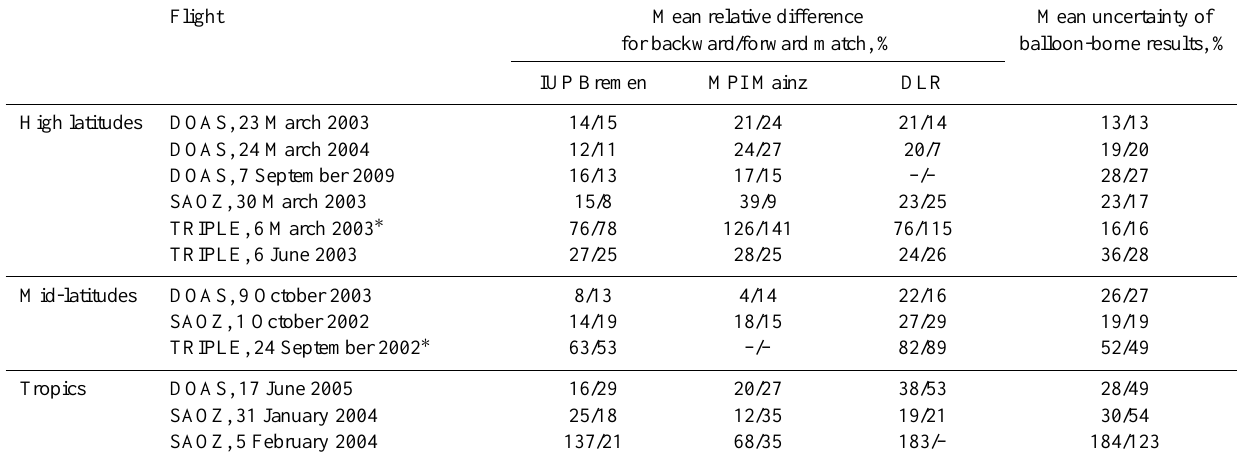
Table 3. Comparison summary. Flight Mean relative difference